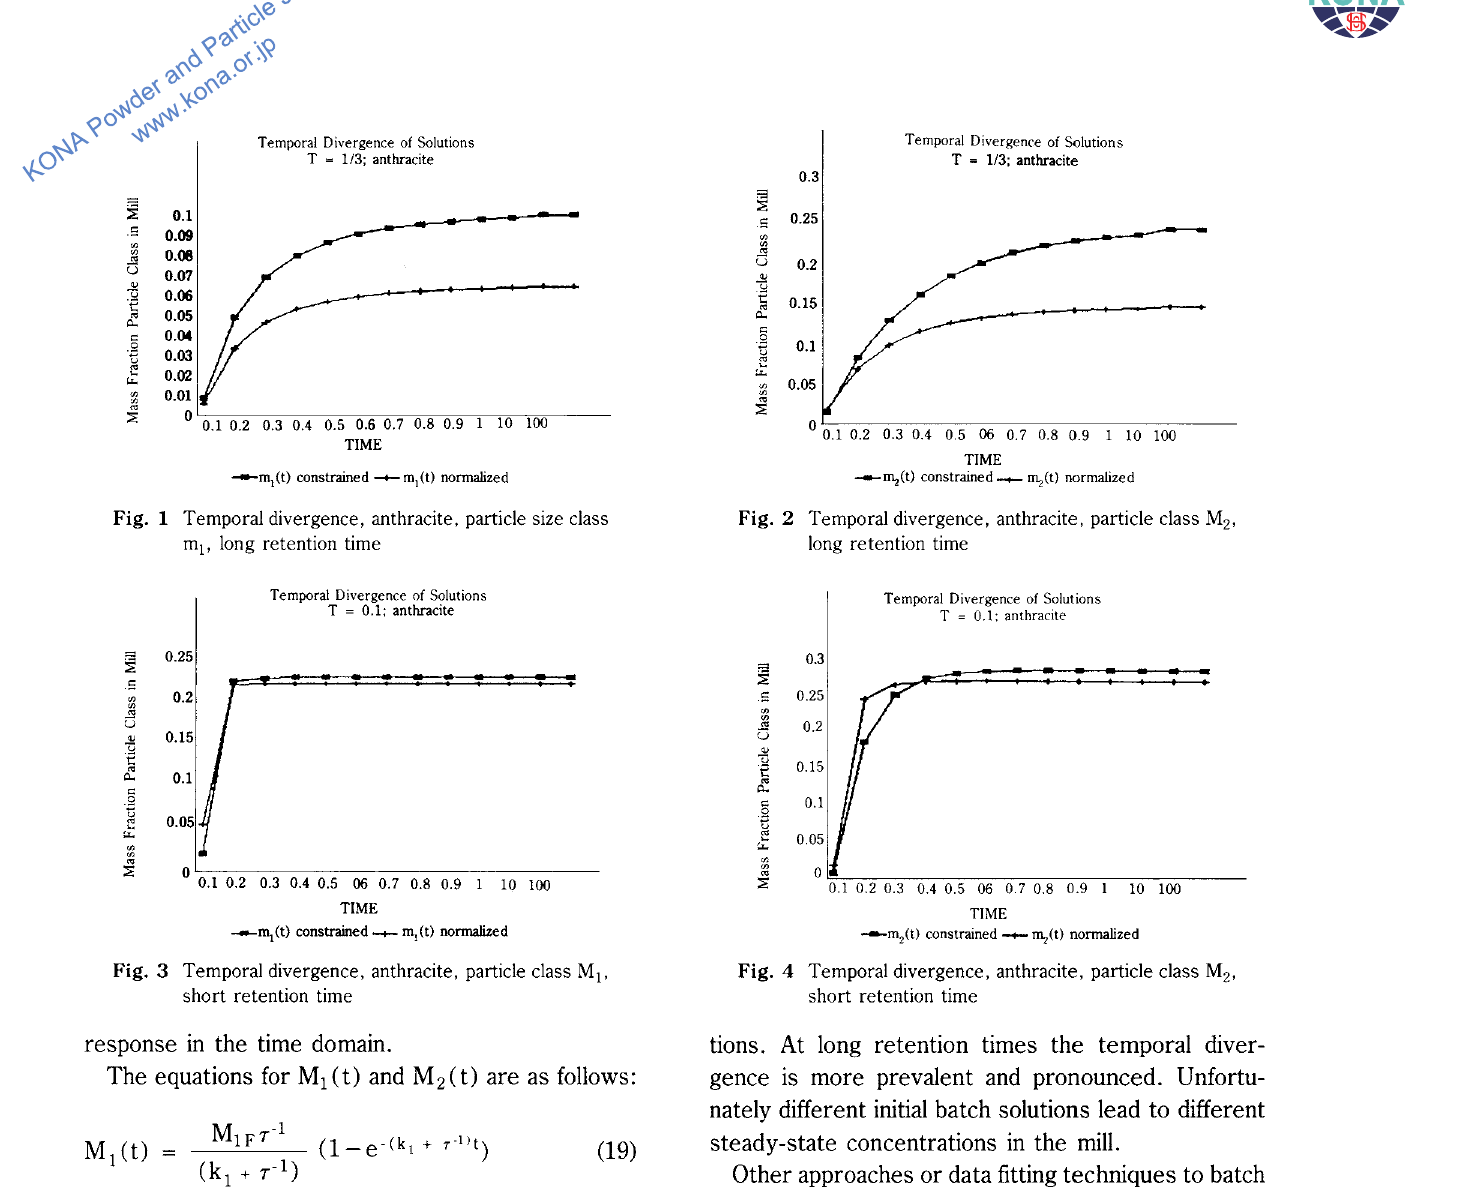
Fig. 3 Temporal divergence, anthracite, particle class M 1, short retention time response in the time domain.